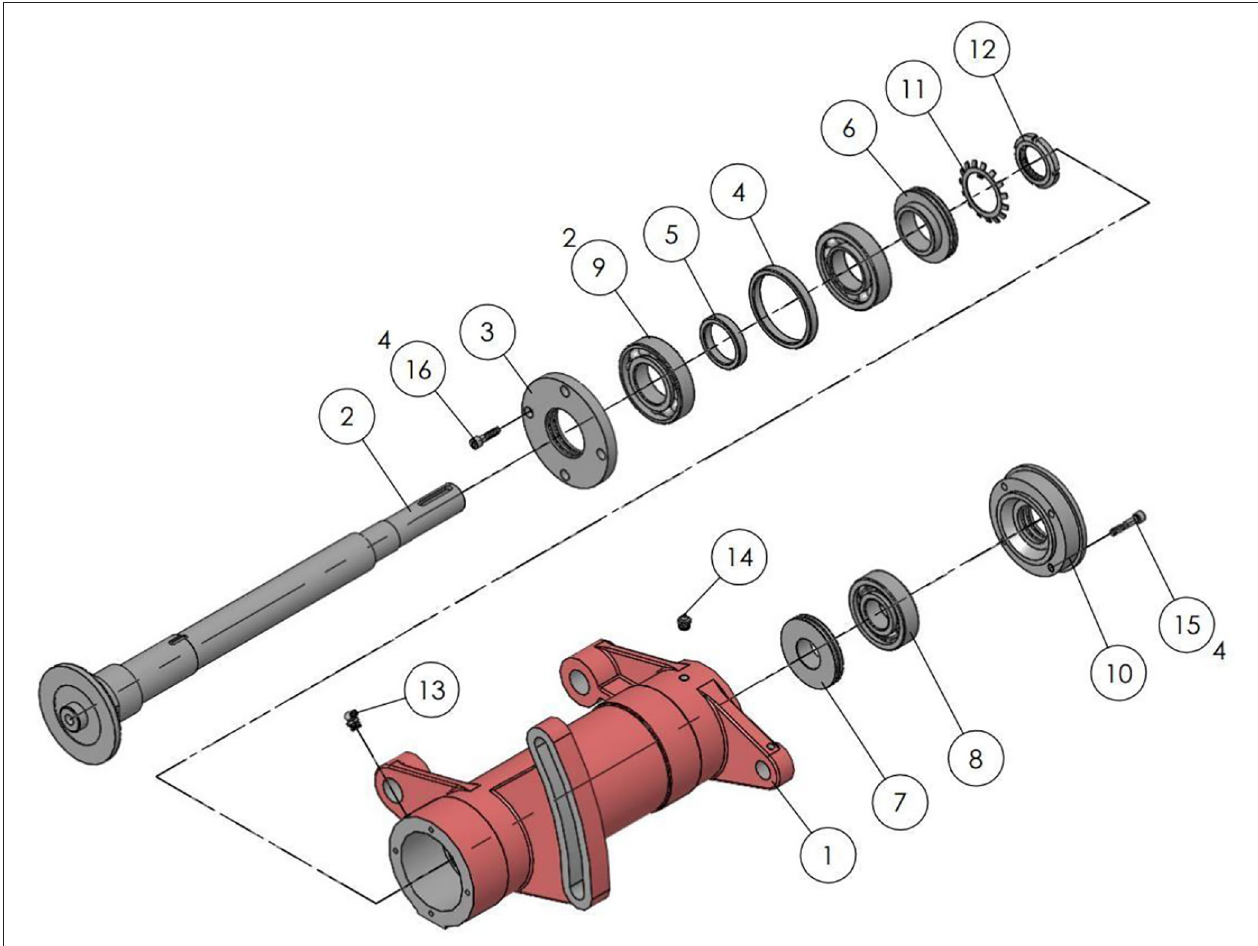
FIGURE 13 | Axis assembly sequence